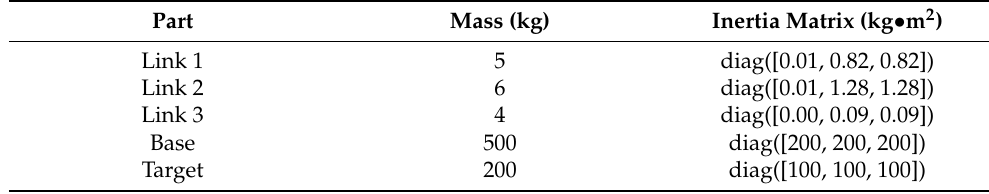
Table 2. Dynamics parameters of 3-DOF free-floating space robot and the